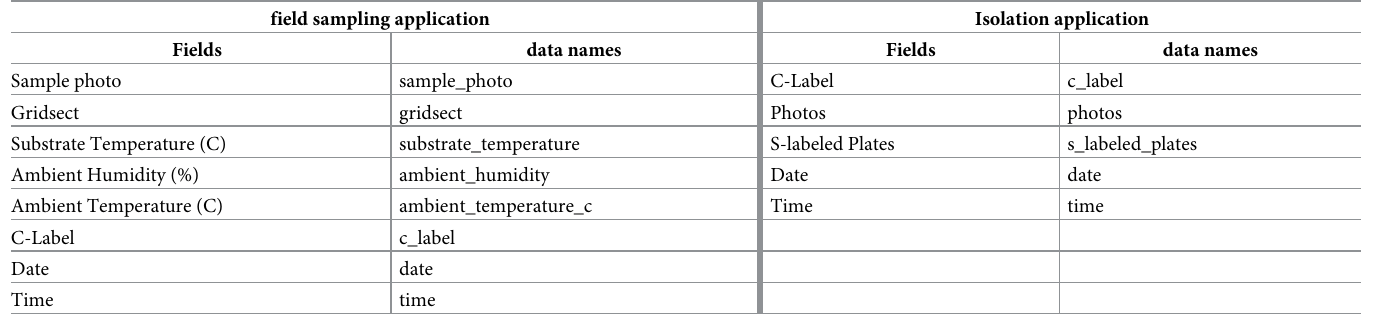
Table 1. Minimum field requirements for customized field sampling and isolation